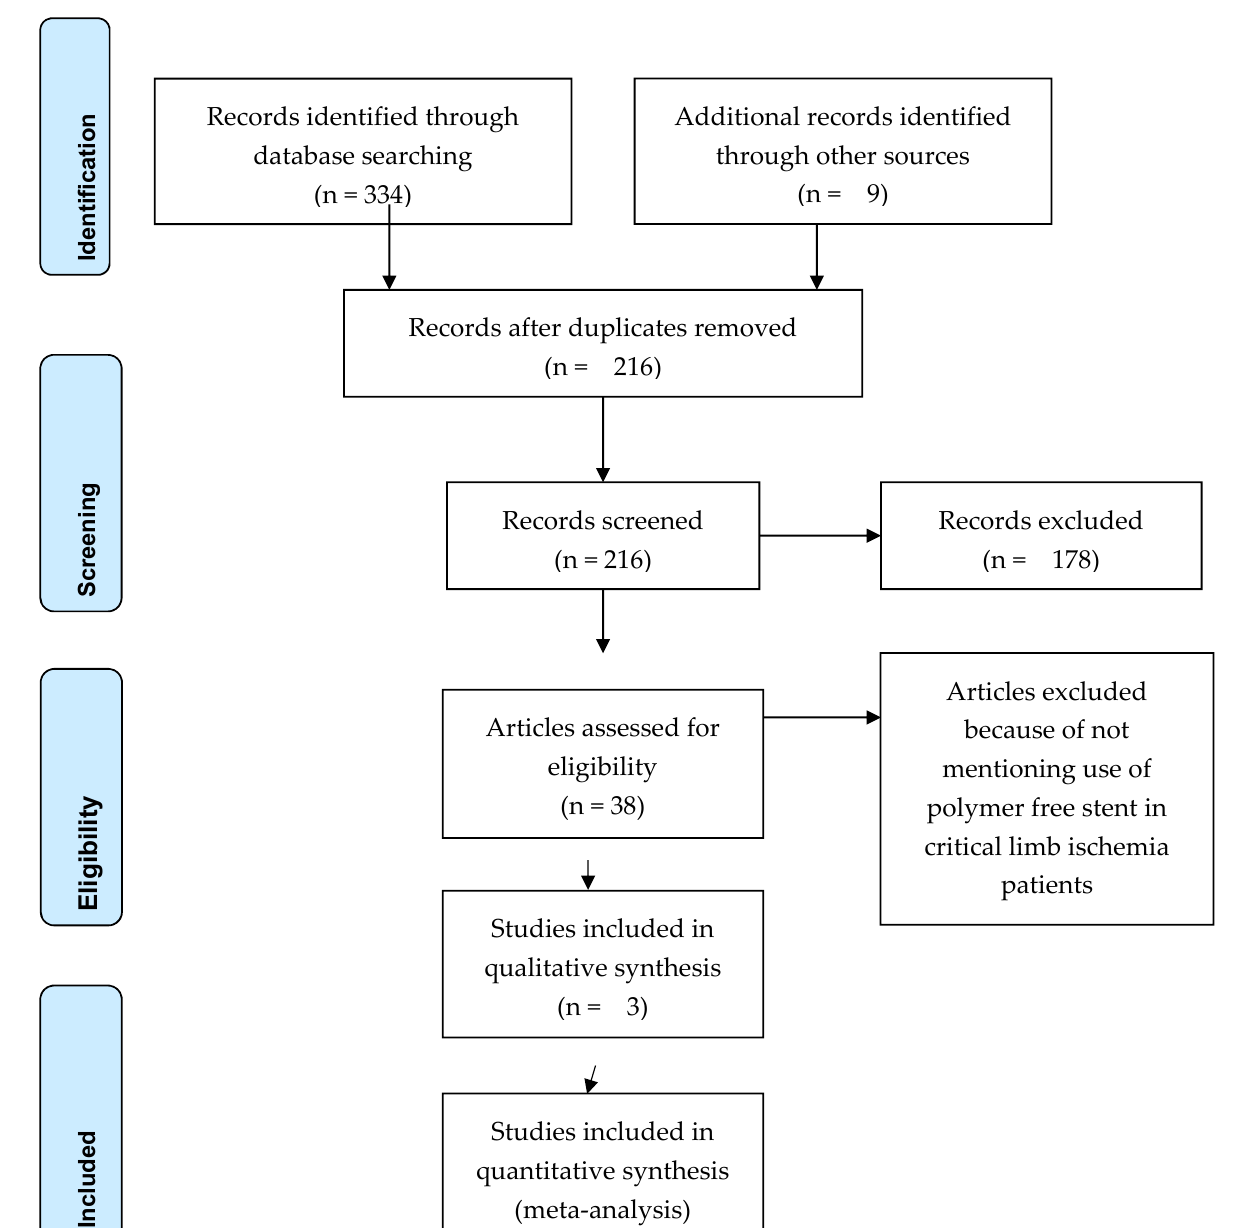
Figure 4. PRISMA flow chart showing study search and selection